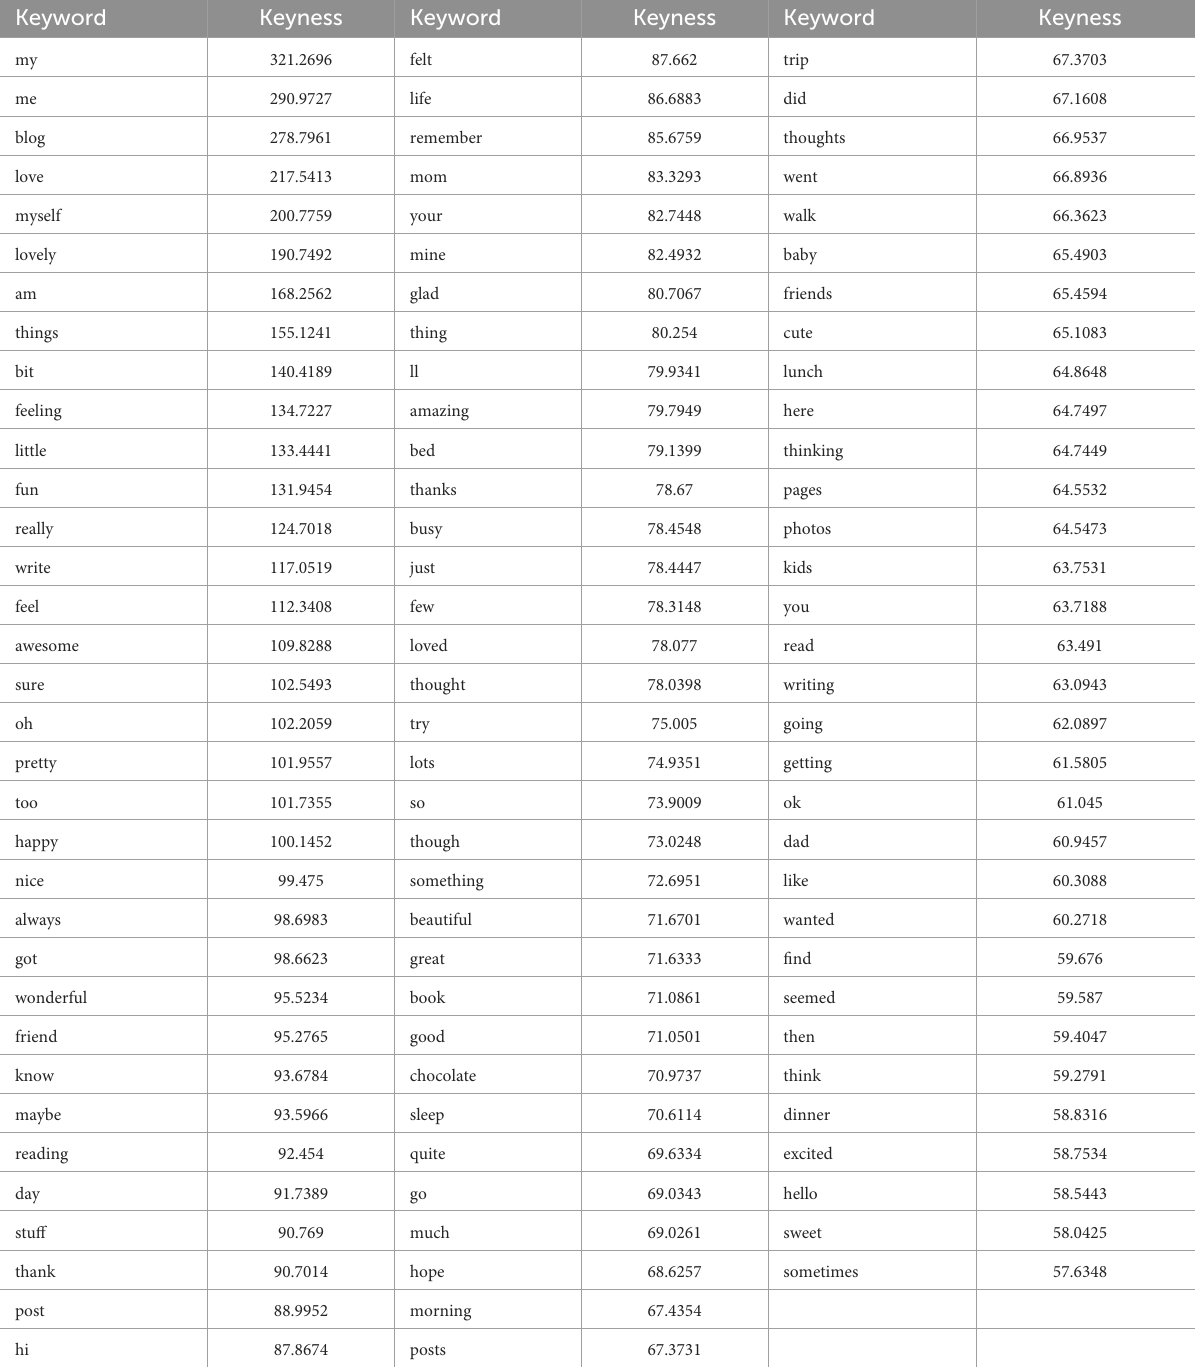
TABLE 4 Top 100 keywords for blogs in descending order estimated with the